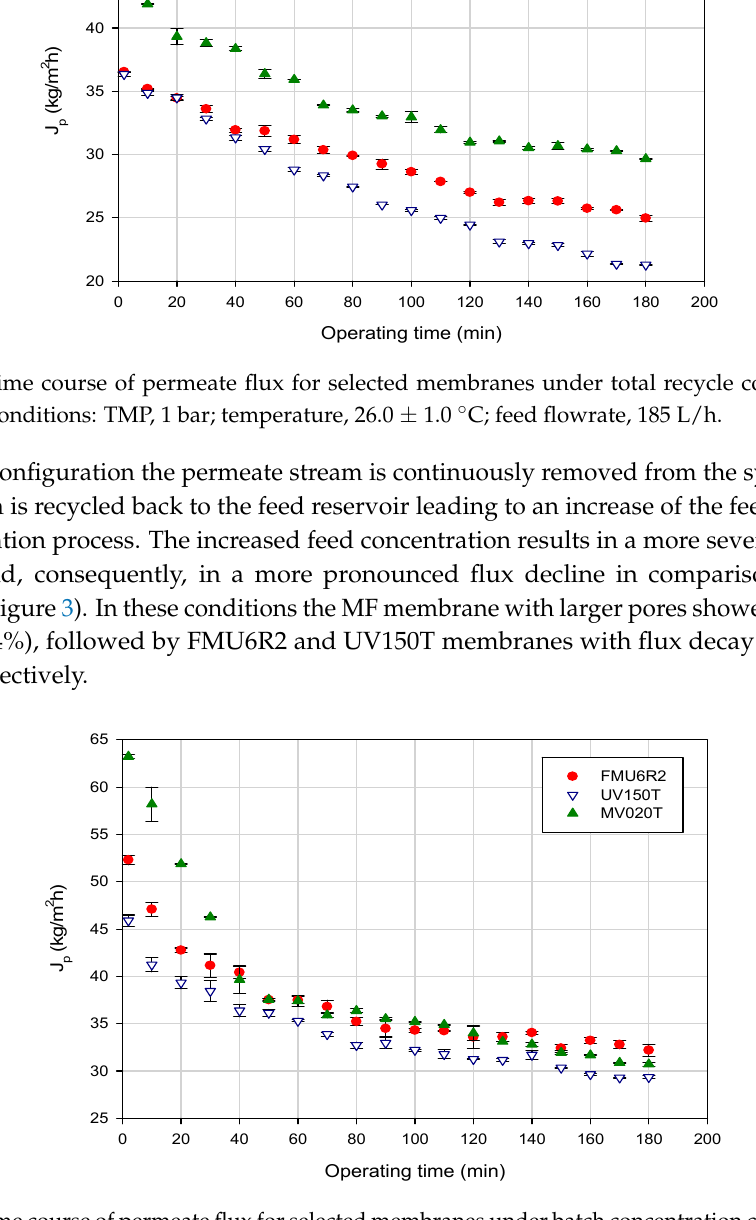
Figure 3. Time course of permeate flux for selected membranes under batch concentration configuration. Operating conditions: TMP, 1 bar; temperature, 26.0 ± 2.0 °C; and feed flowrate, 185 L/h.